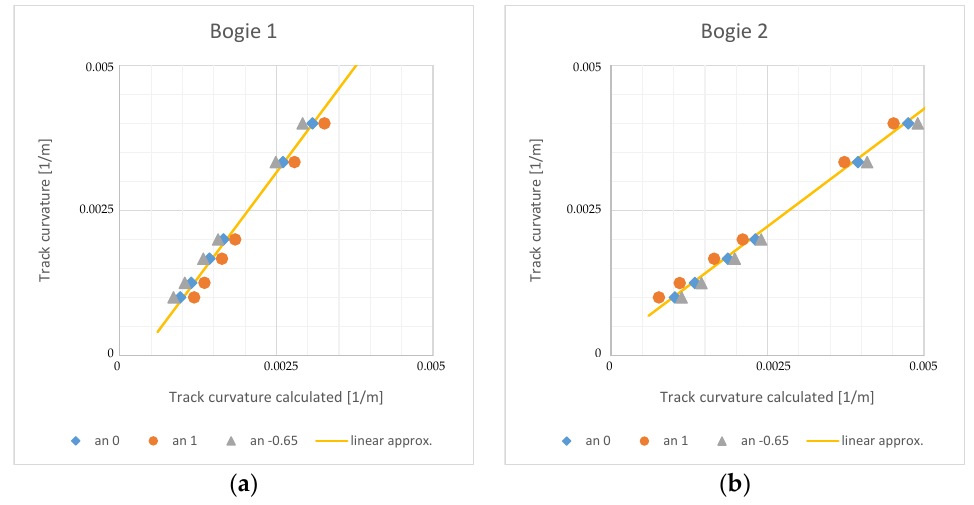
Figure 10. Comparison of the nominal value of the track curvature and track curvature calculated by measurement of bogie to car body angle. Bogie 1 ( a ) and Bogie 2 ( b ).